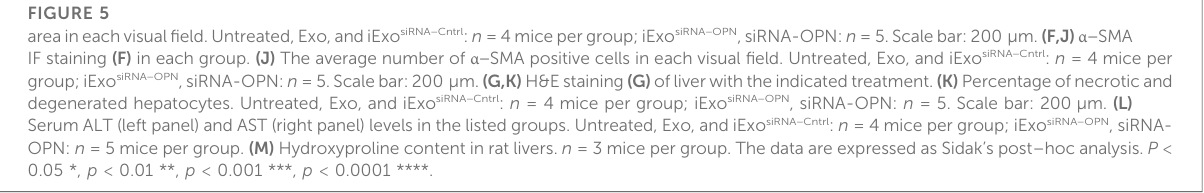
FIGURE 5 areaineachvisual fi eld.Untreated,Exo,andiExo siRNA − Cntrl : n =4micepergroup;iExo siRNA − OPN ,siRNA-OPN: n =5.Scalebar:200 μ m. (F,J) α − SMA IF staining (F) in each group. (J) The average number of α − SMA positive cells in each visual fi eld. Untreated, Exo, and iExo siRNA − Cntrl : n = 4 mice per group;iExo siRNA − OPN ,siRNA-OPN: n =5.Scalebar:200 μ m. (G,K) H&Estaining (G) ofliverwiththeindicatedtreatment. (K)